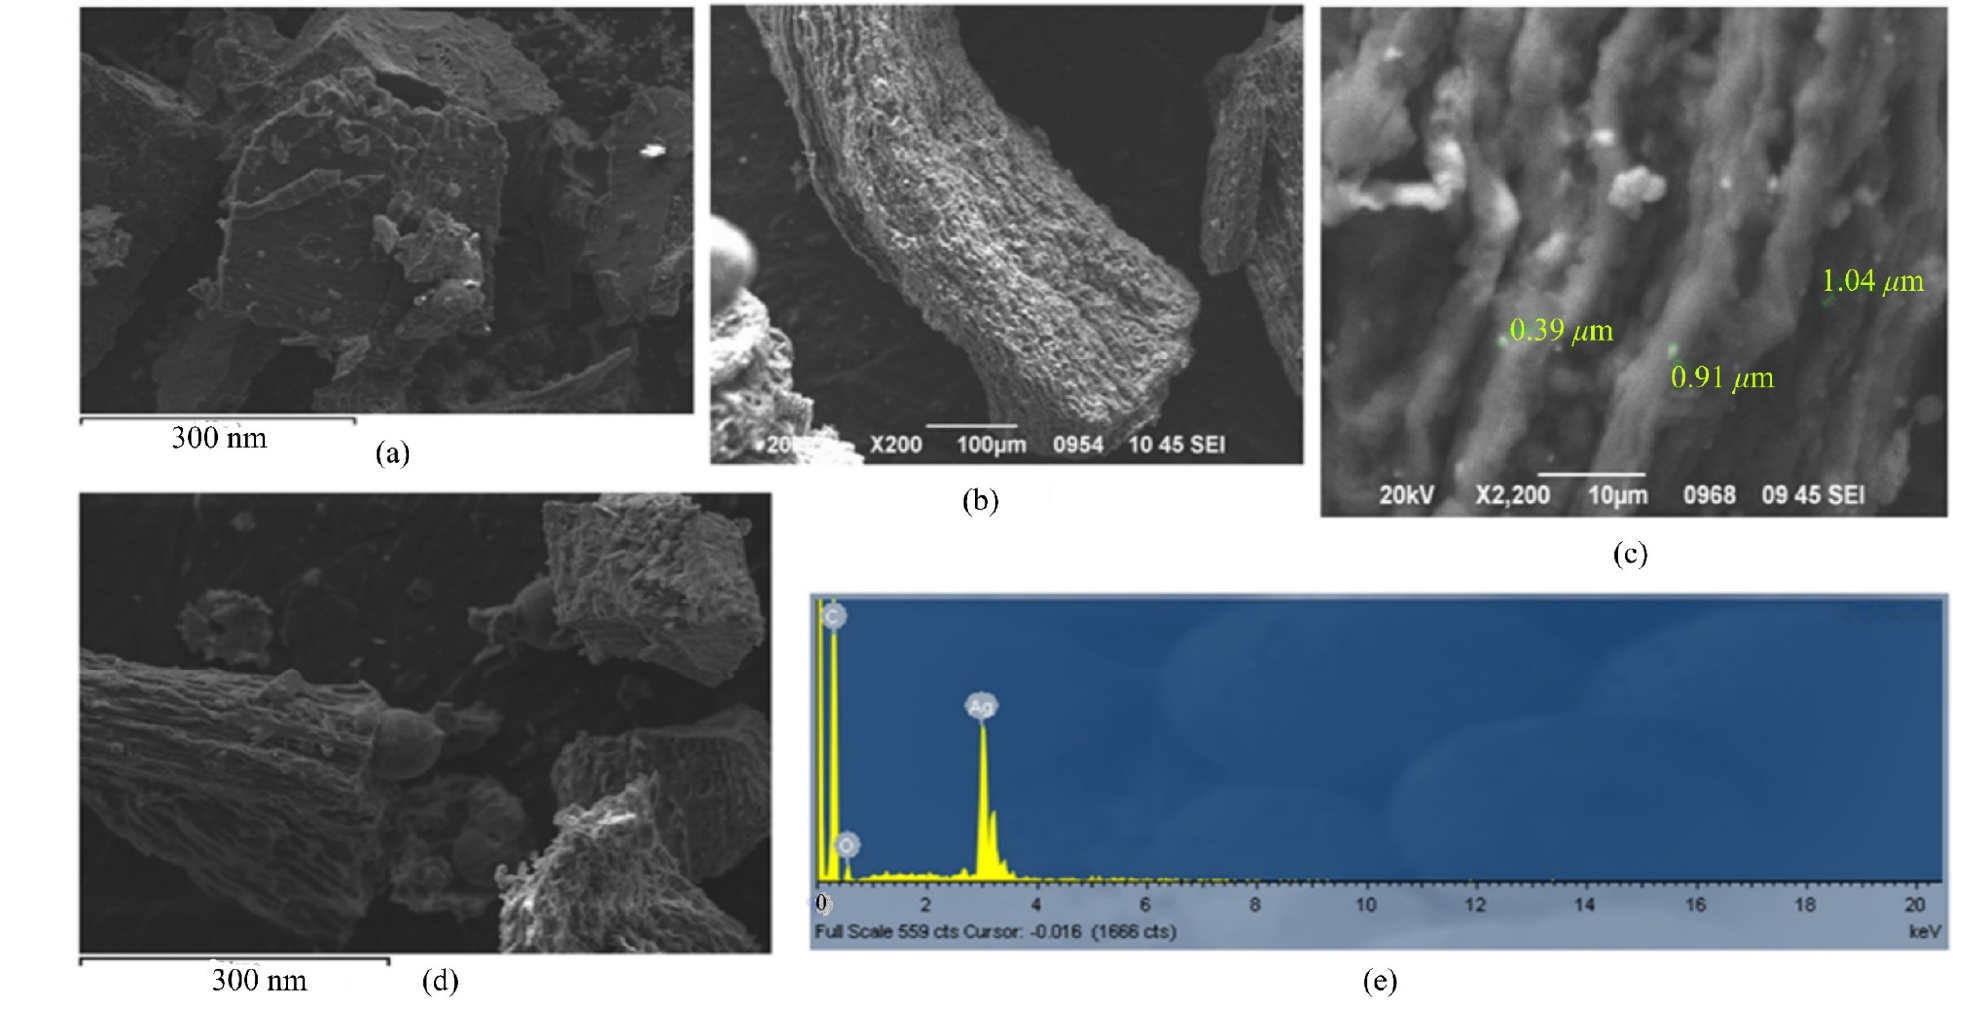
Figure 5. SEM images of ( a ) CPE, ( b , c ) AgSa@NPs.in different magnifications, ( d ) poly-AgNPs@Sa, and ( e ) EDX diagram of AgSa@NPs.